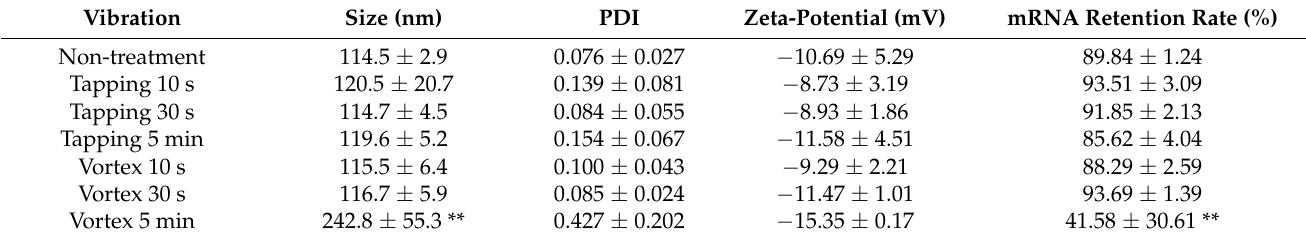
Table 4. Effects of the vibration on particle properties of the mRNA encapsulating LNPs.